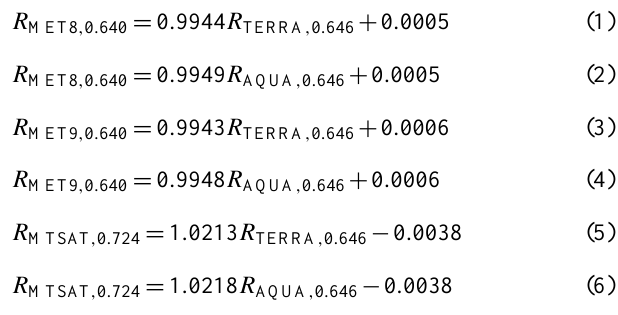
Fig. 2. Spectral relations between two channels. (top) Meteosat- 8 and Meteosat-9 0.640-µm, and MTSAT-1R 0.724-µm channels relating to Terra MODIS 0.646-µm channel. (bottom) Meteosat- 8 and Meteosat-9 0.640-µm, and MTSAT-1R 0.724-µm channels relating to Aqua MODIS 0.646-µm